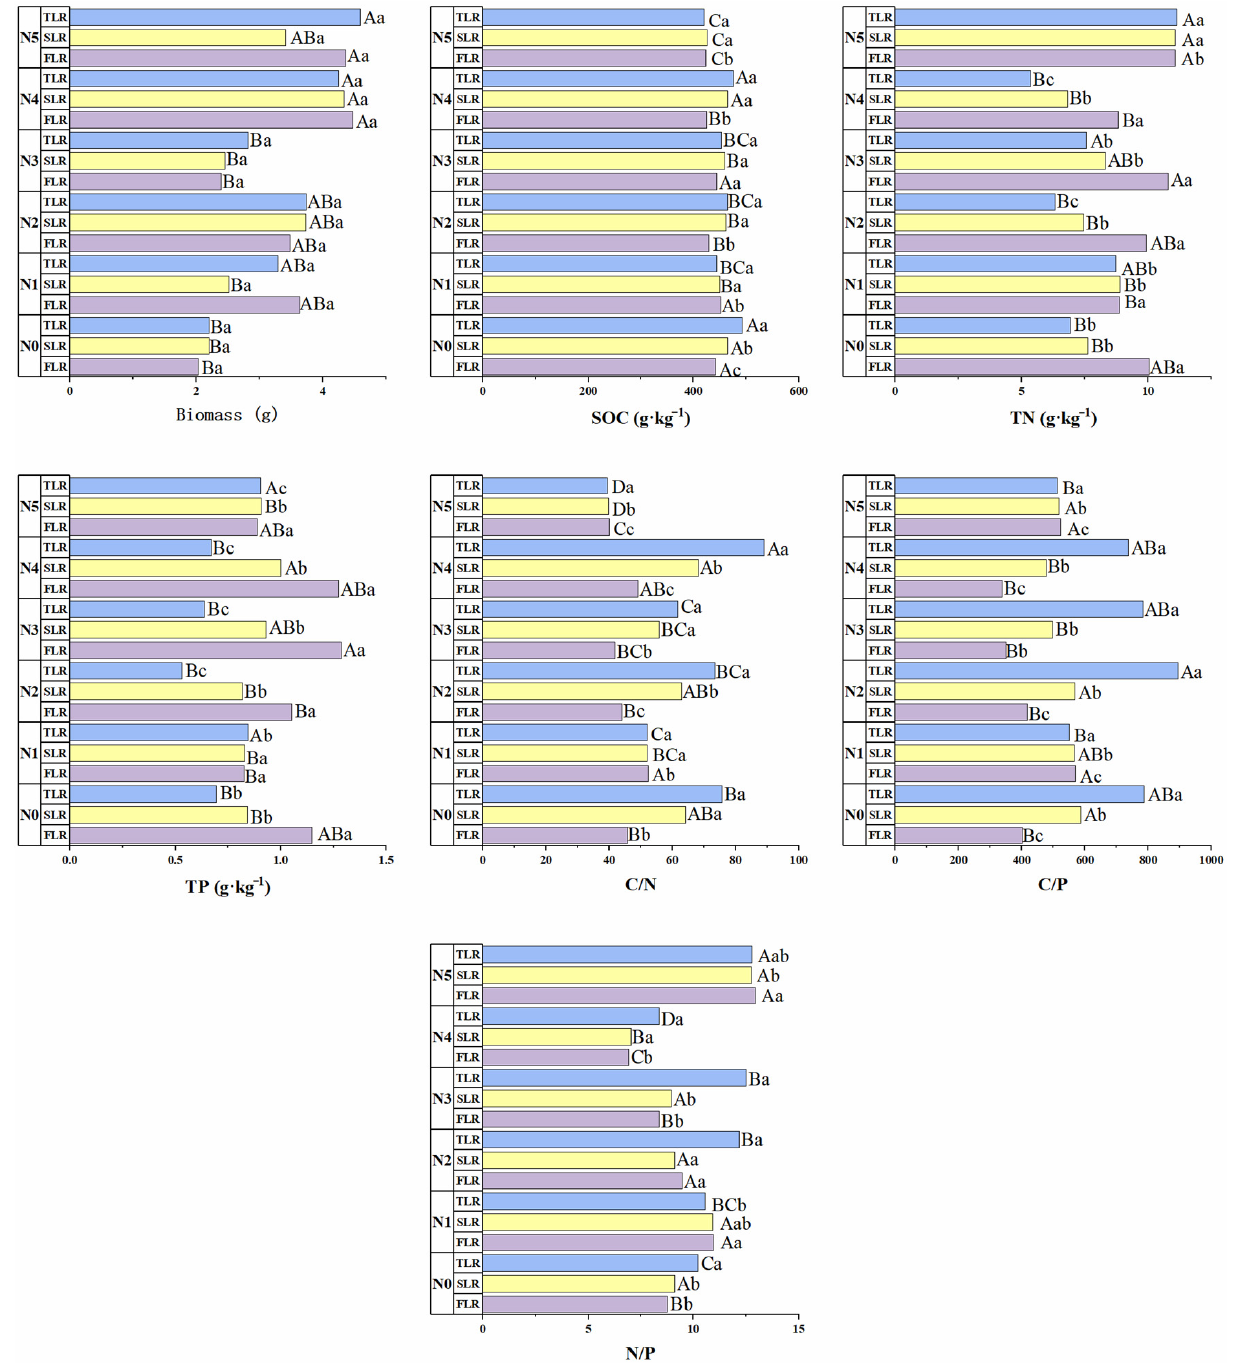
Figure 3. One-way ANOVA for soil ecological stoichiometry and biomass characteristics of Picea schrenkiana with different root sequences at the level of different nitrogen source inputs in the Tianshan Mountains, Xinjiang. FLR is first-order fine roots; SLR is second-order fine roots; and TLR is third-order fine roots. Different capital letters indicate that there is a significant difference in the ecological stoichiometry of elements in the same root order under different nitrogen sources ( p < 0.05); different lowercase letters indicate that there is a significant difference in the ecological stoichiometry of elements in different root orders under the same nitrogen source addition ( p < 0.05).